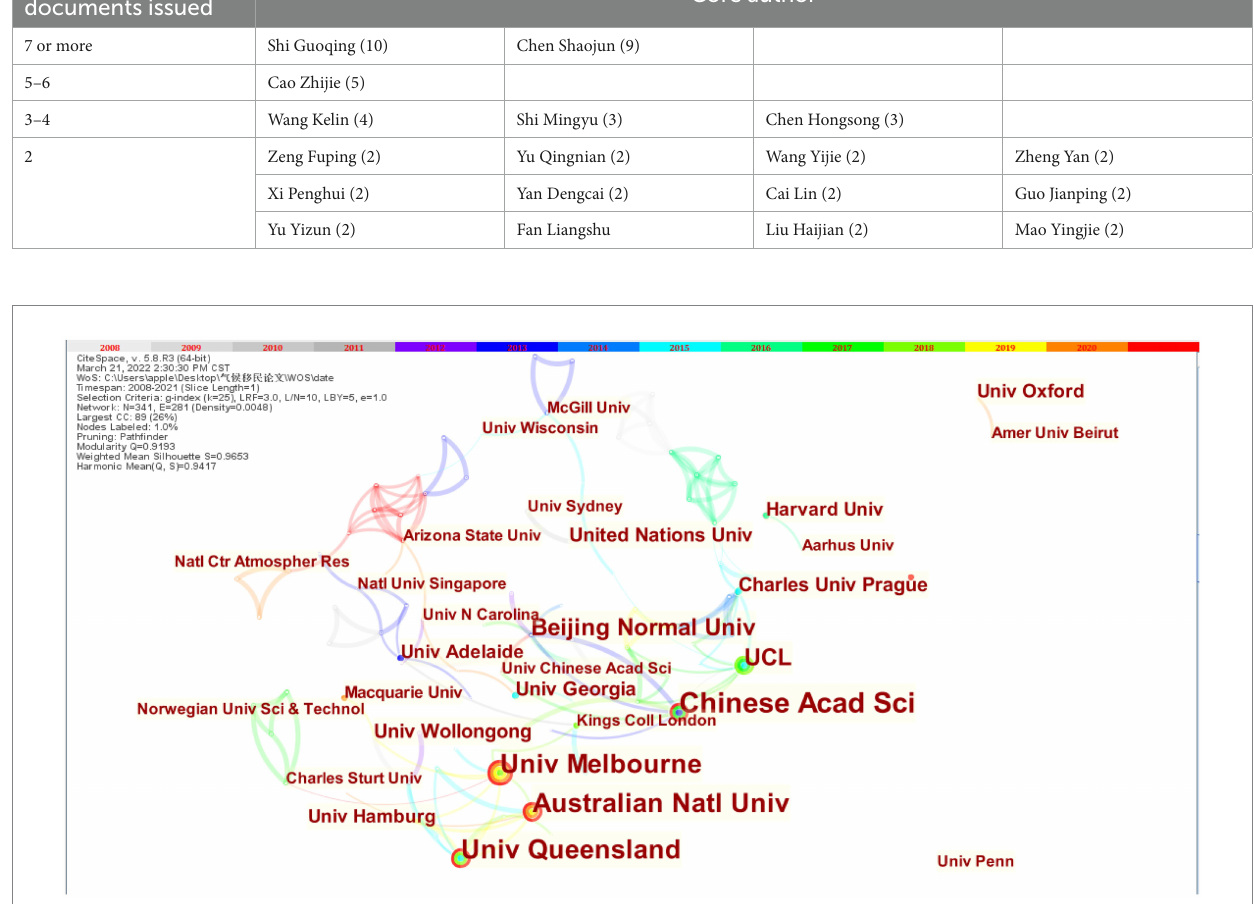
FIGURE 3 Map of the cooperation network of research institutions (WOS 2008–2021).